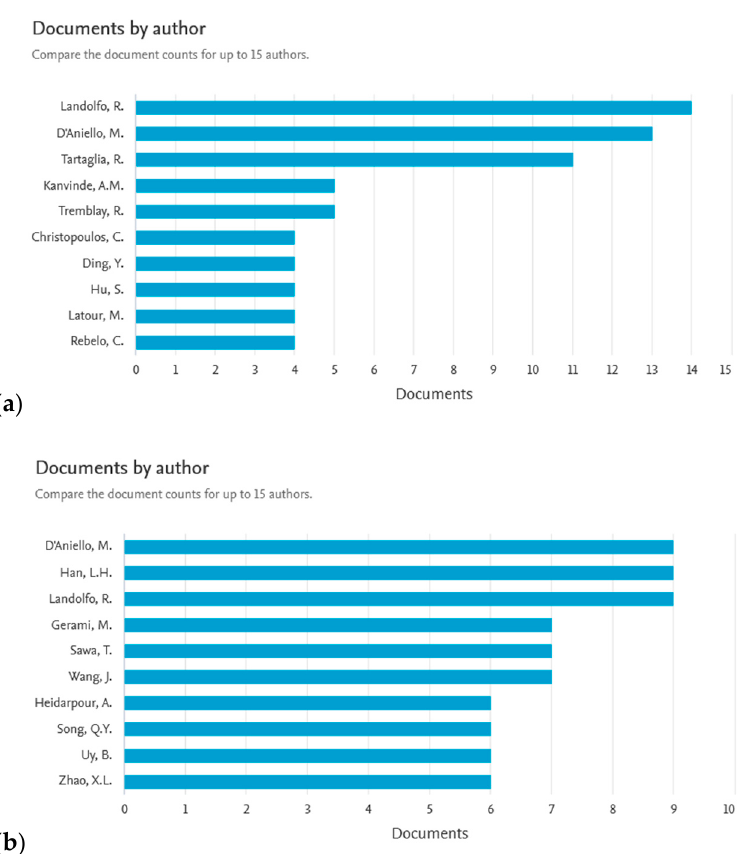
Figure 3. Documents by author for ( a ) “ Seismic design ” AND “ Steel joints ” OR “ Steel Connections ” OR “ Bolted connections ” OR “ Bolted joints ” and ( b ) “ Earthquake ” AND “ Steel joints ” OR “ Steel Connections ” OR “ Bolted connections ” OR “ Bolted joints ”.